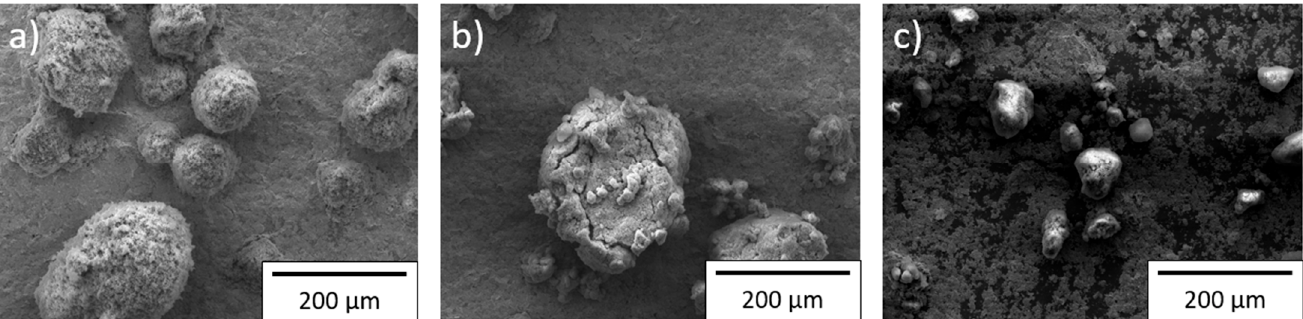
Figure A2. SEM image of the silicon particle agglomerates at 200× magnification for ( a ) NGP, ( b ) TSi, and ( c ) SSN.